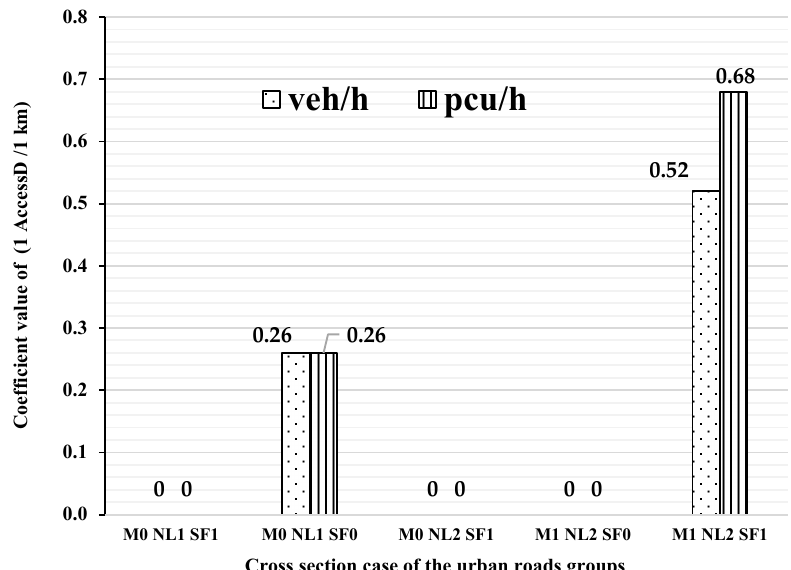
Figure 7. AccessD variation over the five developed models.